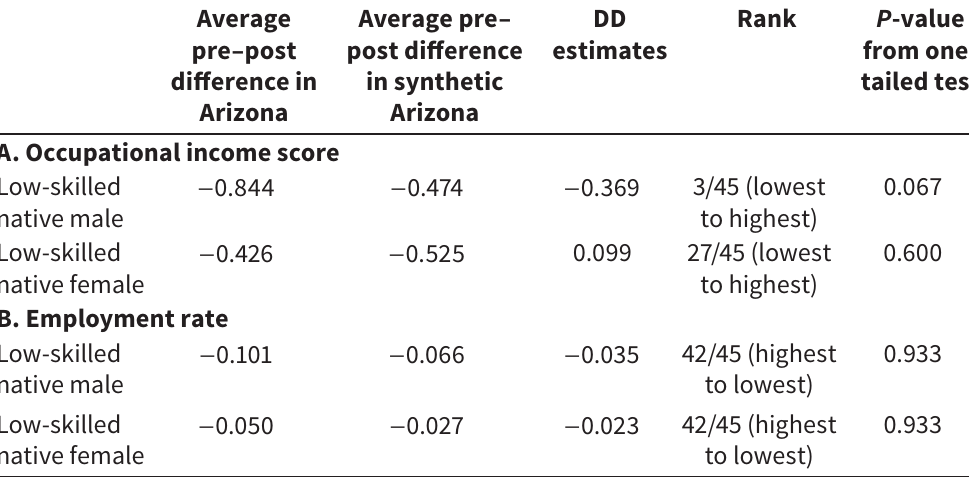
LAWA and occupation income